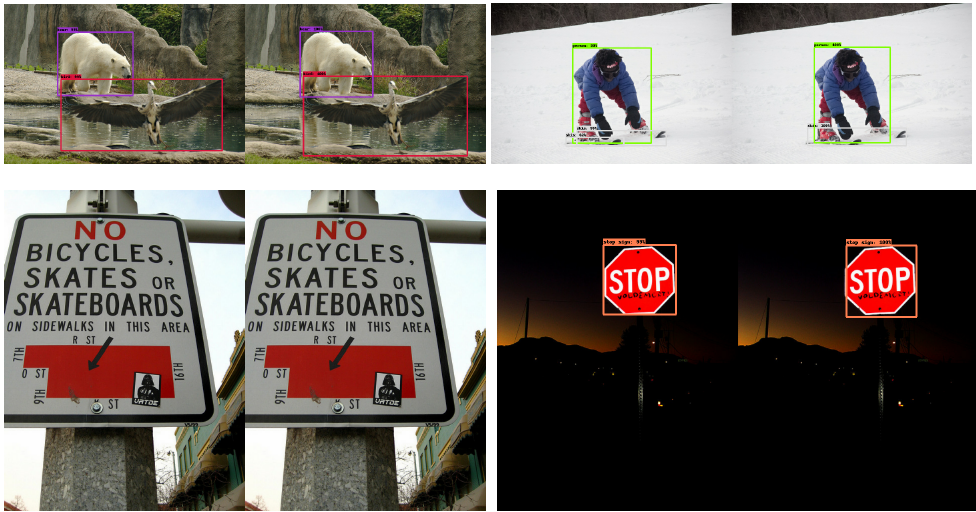
Figure 7. Qualitative results on the COCO val2017 dataset of Faster R-CNN meta-architecture with ResNet-101 + GC backbone. Detection results are on the left side of image pairs, and corresponding groundtruths are on the right side of the